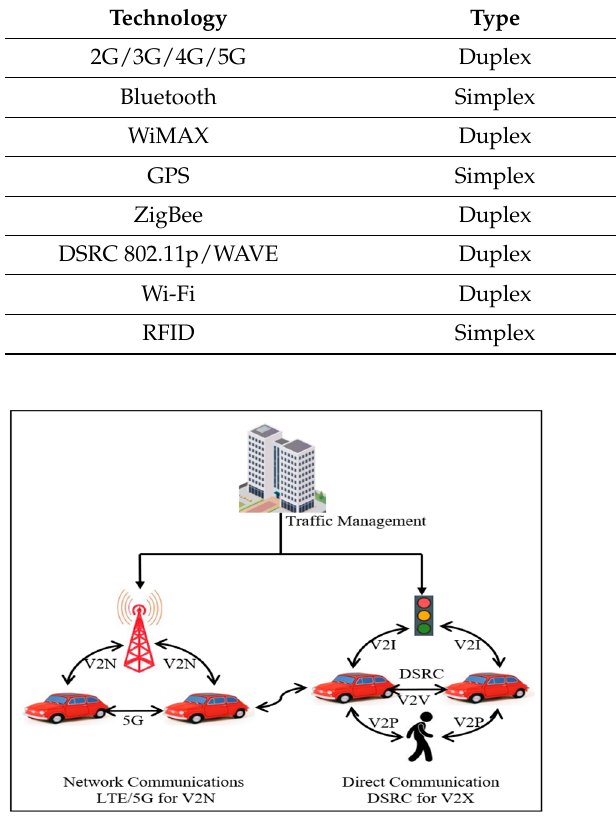
Figure 1. The architecture of vehicular ad hoc communication.